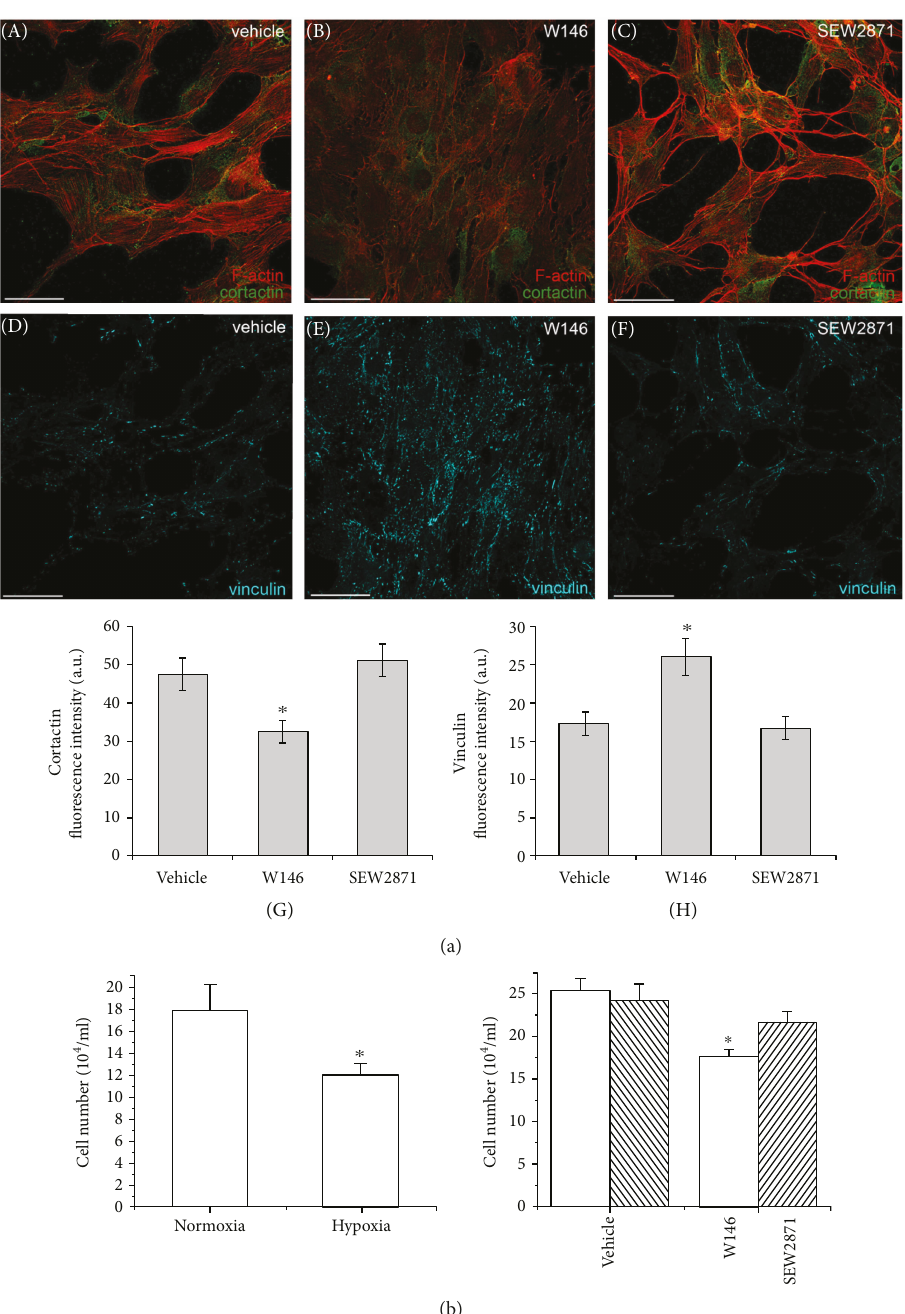
Figure 7: Cytoskeleton organization, cortactin and vinculin expression, and cell proliferation in BM-MSCs cultured under hypoxic conditions. (a, A – F) Representative immuno fl uorescence confocal images of BM-MSCs cultured on glass coverslips for 48 h under hypoxic conditions in the absence (vehicle) or in the presence of 2 μ M S1PR1 receptor antagonist, W146, or 2 μ M S1PR1 receptor agonist, SEW2871, fi xed and stained (A – C) with Alexa 568-phalloidin to detect actin fi laments (red) and immunostained with antibodies against cortactin (green) and (D – F) with antibodies against vinculin (cyan). Scale bar 50 μ m. The images are representative of at least three independent experiments with similar results. (a, G and H) Densitometric analyses of the intensity of the (G) cortactin and (H) vinculin fl uorescence signals performed on digitized images. Data are mean ± S.E.M. (b) Cell proliferation analysis by cell counting. Synchronized BM-MSCs were incubated in growth medium for 48 h in normoxia and hypoxia (histogram on left) or in hypoxia in the absence (vehicle) or in presence of 2 μ M S1PR1 receptor antagonist, W146, or 2 μ M S1PR1 receptor agonist, SEW2871 (histogram on the right). Cells were collected and counted by TALI Cytometer as reported in Section 2. Data are mean ± S.E.M. of four independent experiments performed in quadruplicate. Signi fi cance of di ff erences in (a) (G and H, Student ’ s t -test), ∗ p < 0 05 versus vehicle; in (b) (Student ’ s t -test), ∗ p < 0 05 versus normoxia or